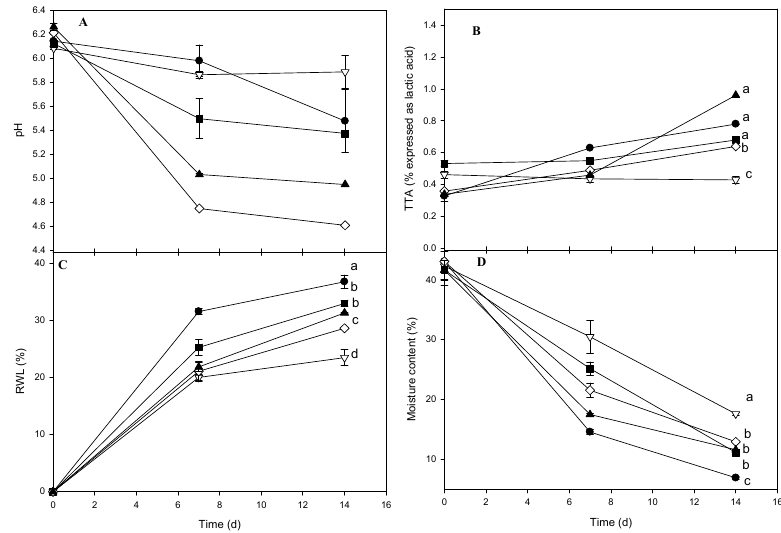
Figure 2. Time course of pH ( A ); TTA ( B ); RWL ( C ) and moisture content ( D ) of chesses inoculated with L. monocytogenes stored at 4 °C and 22% RH coated with different materials. Control (uncoated) ( ); LDPE ( (cid:53) ); ChLA ( (cid:4) ); ChLA-TSA ( ♦ ) and ChLA-TSA-SPI ( (cid:78) ). Data are the average of three determinations. Plots with the same letter in a graph are not significantly different at p < 0.05 as determined by multiple comparisons of means by the Tukey-Kramer test. Continuous lines are included only as a visual guide.